Question: In a single sentence, describe what this figure presents.
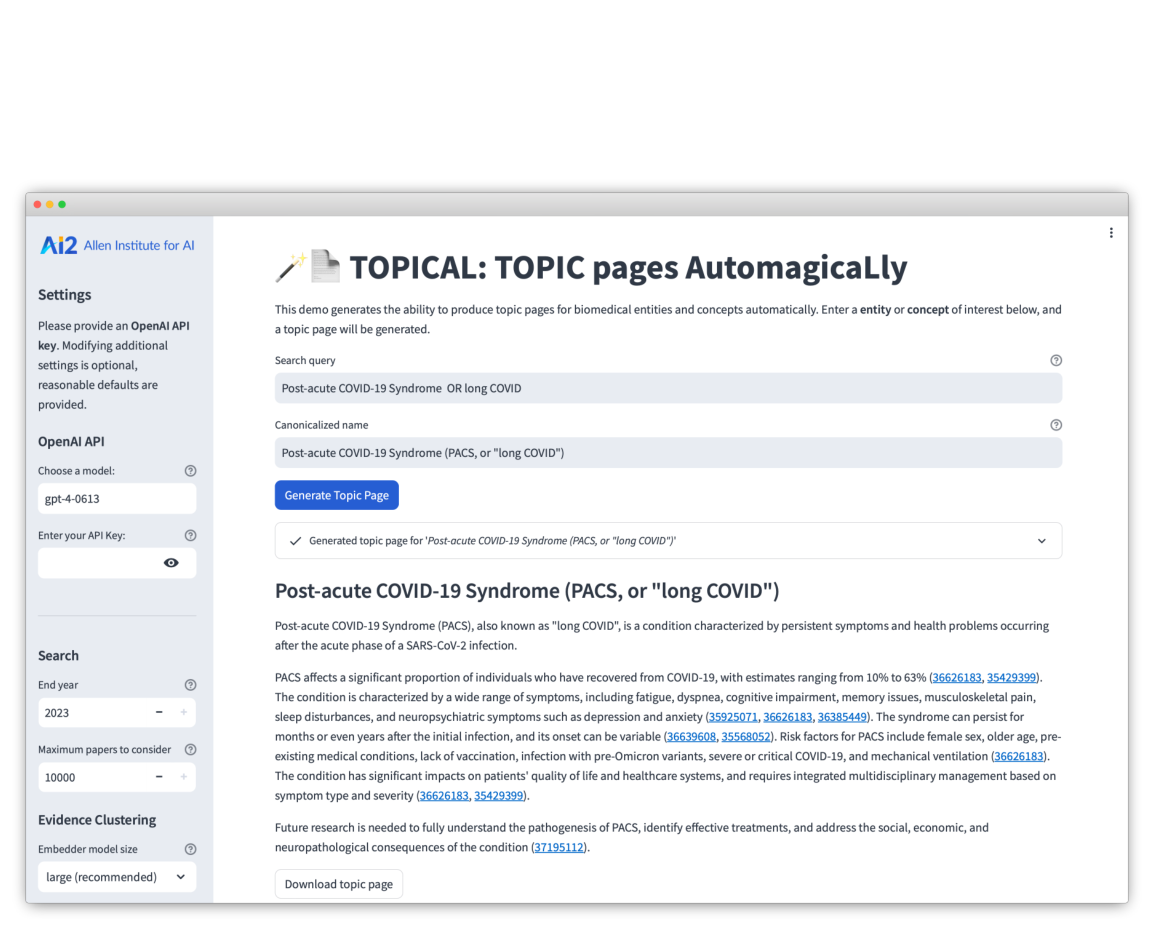
Answer: TOPICAL web app. Given a search query for a biomedical entity or concept of interest and a canonicalized name, it automatically generates a topic page for the concept. An expandable section provides additional information, like a histogram of publication dates for the query and the number of clusters identified.